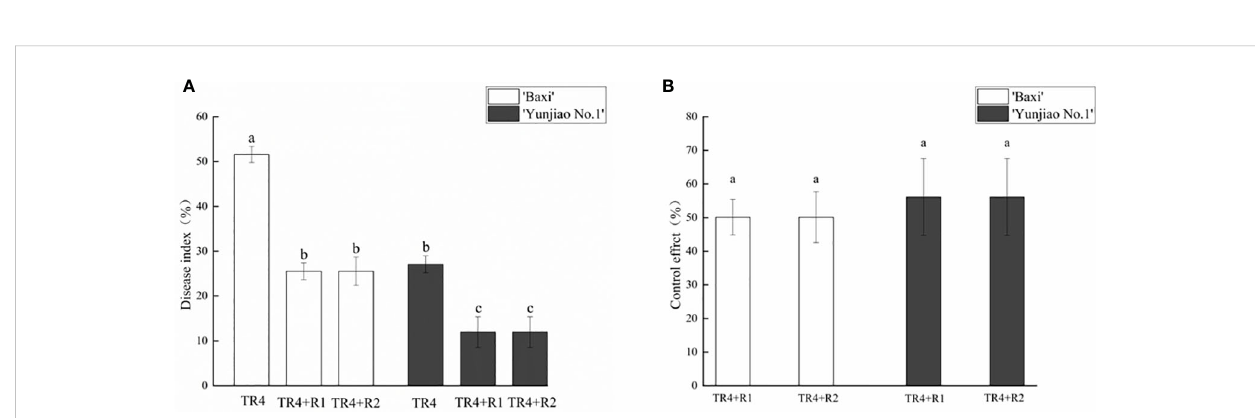
FIGURE 3 Effect of isotianil application on banana plants after inoculated TR4. (A) Disease index of all treatments. (B) Control effect of application with isotianil. The data represents three independently repeating values. Based on Duncan ’ s multiple range test, a signi fi cant difference was determined at P<0.05. Error bars represent ± standard